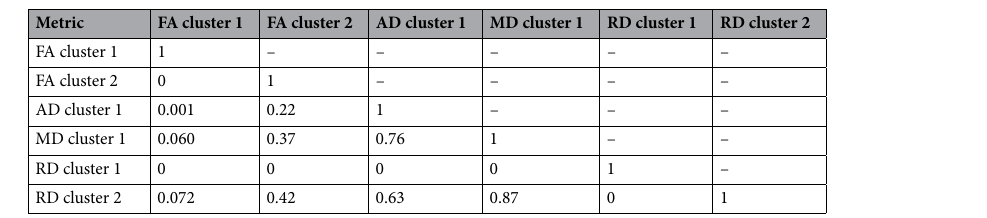
Table 2. Dice coefficient between each pair of significant clusters.